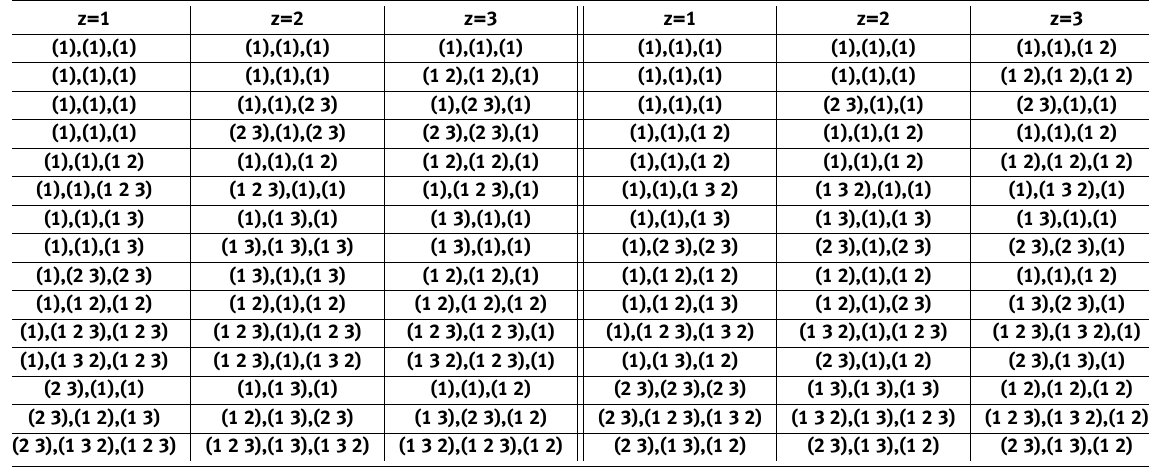
Table 3. Isomorphism classes of ternary quandles of order